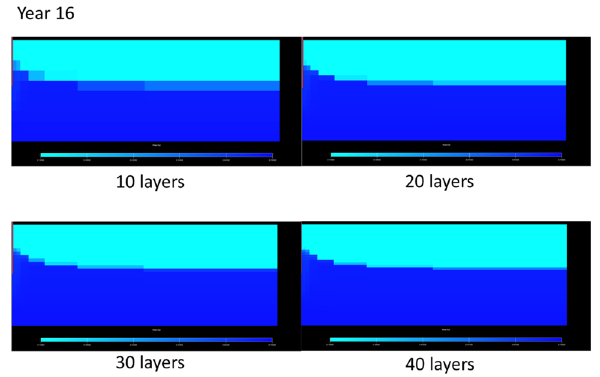
Fig. 15 Water saturation profile along a reservoir radius for 4 models